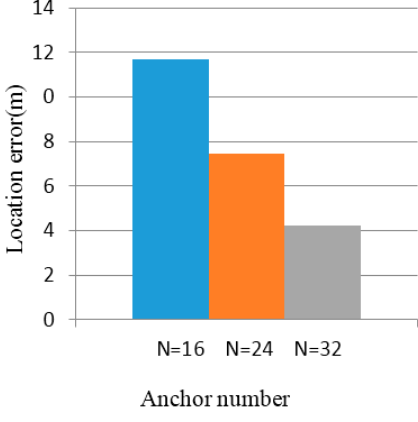
Figure 21. Location errors with intensity value fluctuation of 10%.